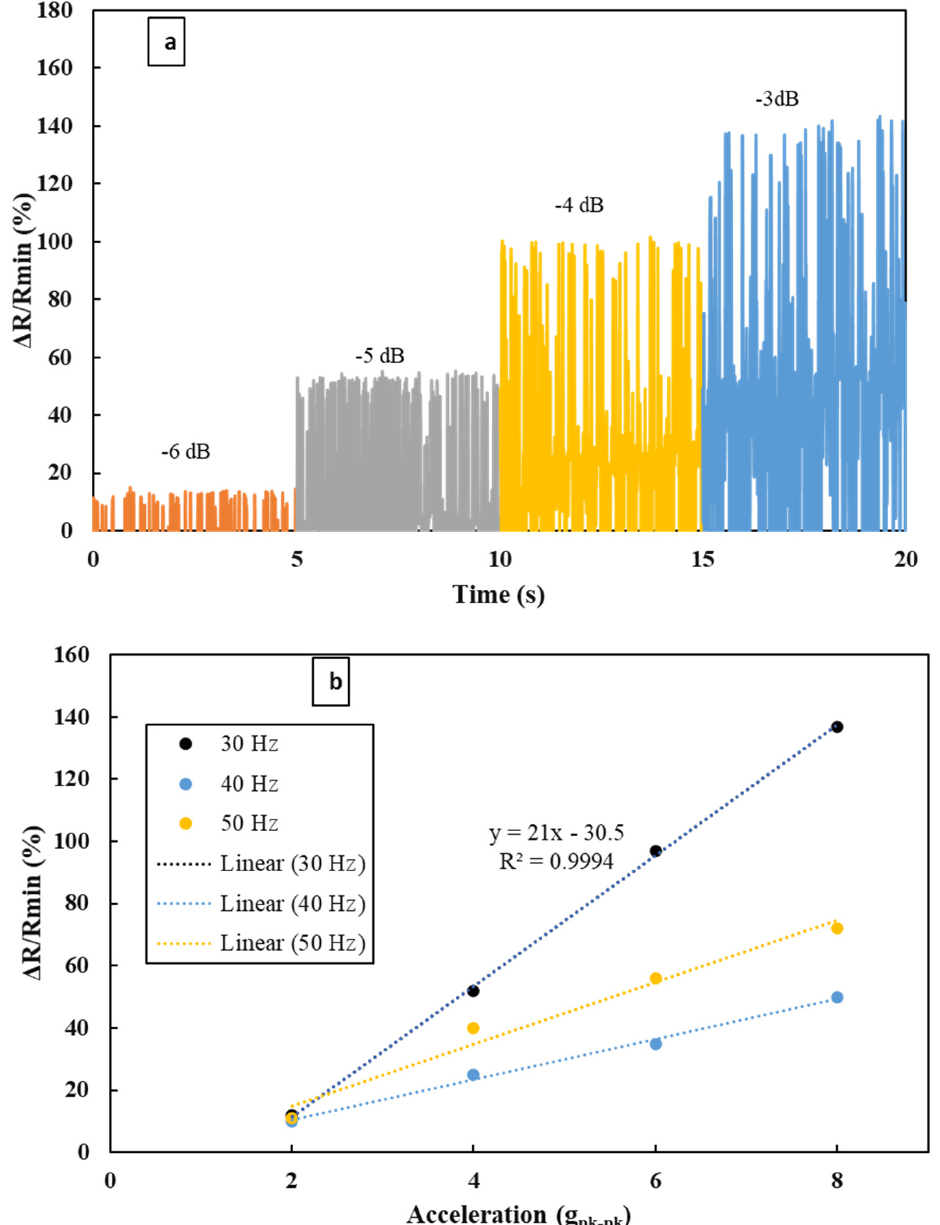
Figure 5. ( a ) Repeatability test at a representative frequency of 30 Hz for different amplitudes ranging from − 6 dB to − 3 dB. ( b ) Response measurement at a representative frequency of 30 Hz, 40 Hz, and 50 Hz for different g values.